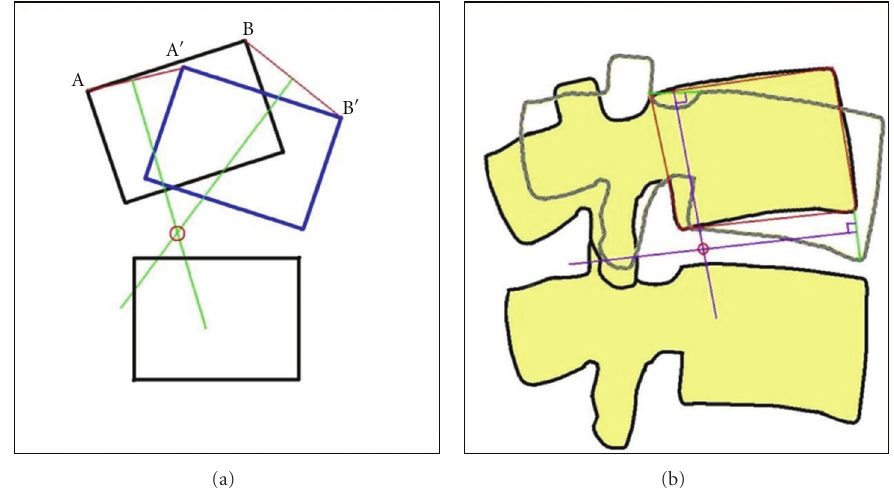
Figure 7: Illustration of geometric determination of IAR: (a) on a simple block diagram, (b) on vertebral body images. The IAR is located in the posterior half of the disc space.